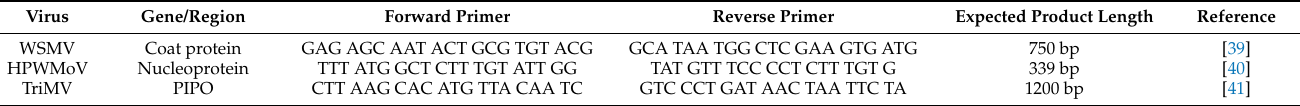
Table 1. Sequences of oligonucleotide primers used in this